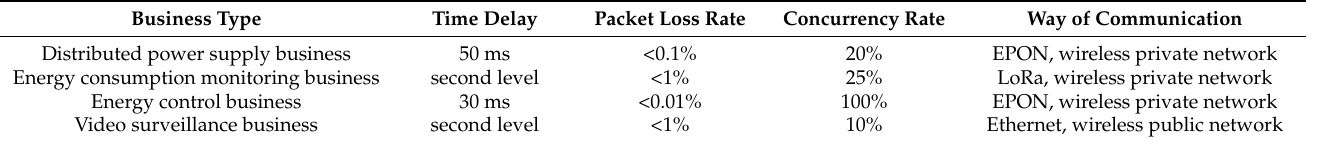
Table 1. Typical QoS indicators of communication services in smart